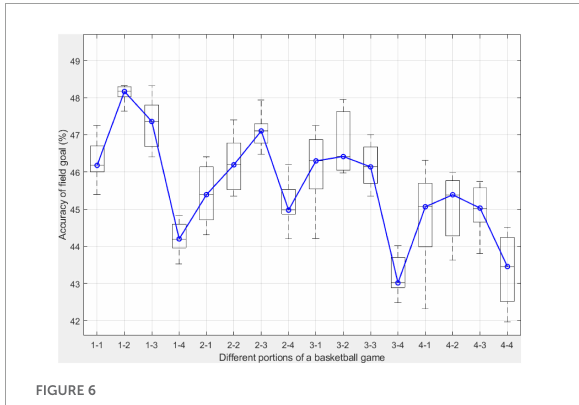
FIGURE6 The accuracy of field goals from different 3-min segments in a basketball in the past decade. Each boxplot is comprised of 10 values, each corresponding to one NBA regular season in this study. The blue line connects the median of the boxplots.